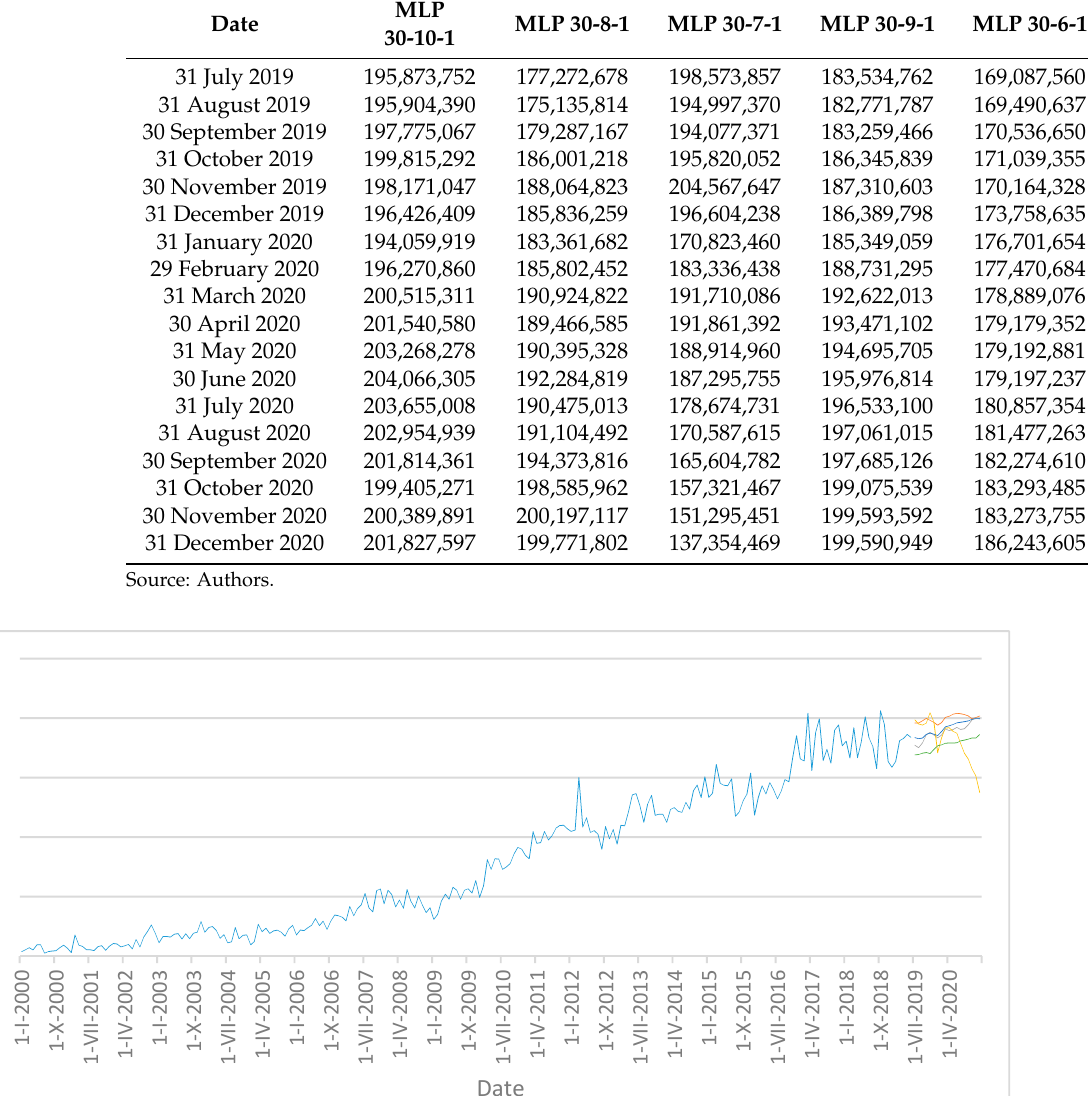
are presented in Table 7. Table 7. Predicted exports from July 2019 to December 2020 according to the retained ANN (Experiment 3) .